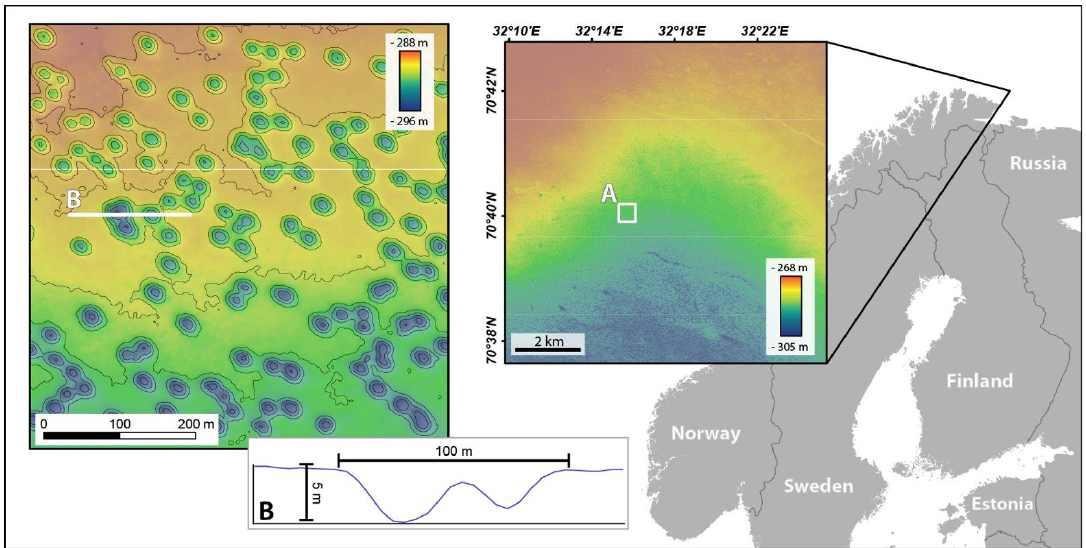
Figure 4. Barents Sea dataset (Norway). Location map of the Barents Sea dataset (Norway) and bathymetric map obtained by MAREANO. ( A ) Detailed view of the bathymetric map (contour lines every 1 m) and localization of profile ( B ), across two pockmarks.